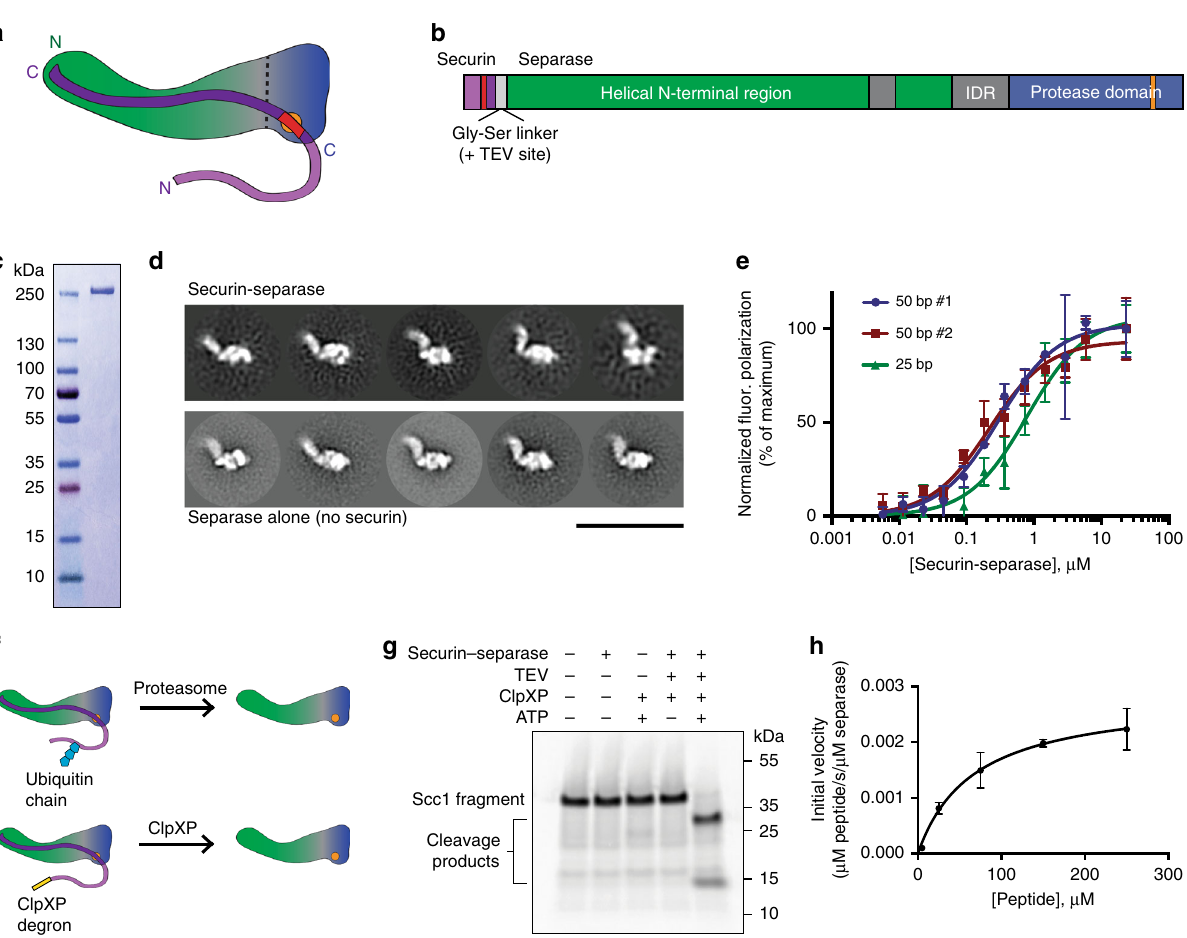
Fig. 1 Production of active separase. a Cartoon of the securin-separase complex. The vertical dashed line indicates an approximate delineation between the separase N-terminal helical domain (green) and C-terminal protease domain (blue) containing the active site (orange). The C-terminal region of securin (dark purple) binds in an antiparallel fashion along the length of separase, and begins with the pseudosubstrate motif (red) bound in the separase active site. The N-terminal region of securin (light purple) contains the APC/C degrons. b Diagram of the securin-separase fusion construct. Colors correspond to a . Also depicted are the fl exible Gly-Ser linker separating securin and separase (light gray) and the regions of human separase predicted to be intrinsically disordered (IDR, dark gray). See Supplementary Fig. 1a for amino acid sequence. c Puri fi ed securin-separase fusion protein was analyzed by SDS – PAGE and stained with Coomassie Blue, using molecular weight markers as indicated. d Puri fi ed securin-separase (top) and apo (active) separase (bottom) were analyzed by negative-stain EM, and fi ve representative class averages of each preparation are shown. Scale bar: 40 nM. e Securin-separase binding to fl uorescein-labeled DNA was evaluated by fl uorescence polarization. Two 50 bp dsDNA molecules with the same base composition but different sequence were tested, as well as a 25 bp molecule. Data points indicate means (±SD) of triplicate samples. Source data are provided in the Source Data fi